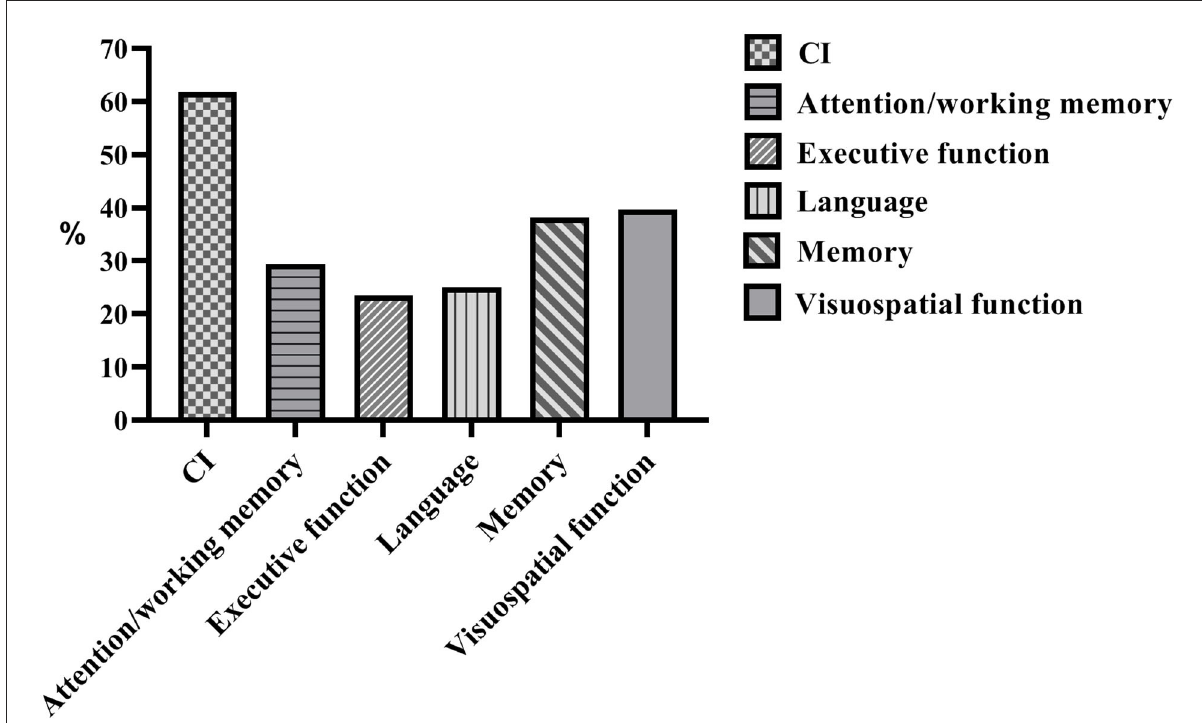
FIGURE1 The frequencies of abnormal performances in global and individual cognitive domains of patients with CD. CI, cognitive